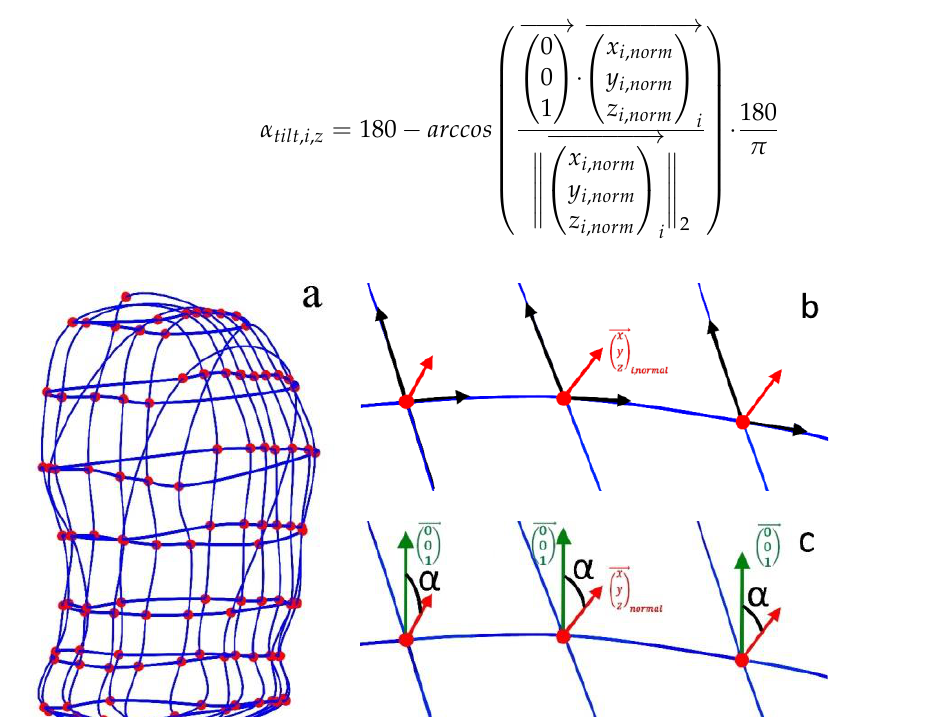
Figure 7. Illustration of the closed spline curves (blue) through horizontal and vertical marker sets, used to obtain tilt angles at the MoCap marker (red) positions ( a ) and the normal vectors (red arrows) to the tangent planes in the marker positions, spanned by the directional vectors—the derivatives of the spline curves (black arrows in ( b )). The z-direction of the coordinate system is illustrated in green ( c ), and the obtained tilt angles α (black in ( c )) are the angles between the z-direction and the normal vectors.